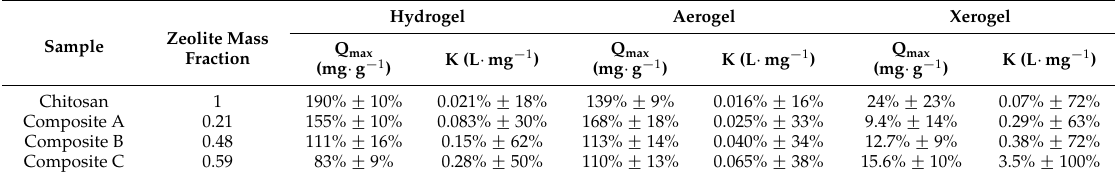
Figure 6. Cu(II) sorption on zeolite X (void lozenges), chitosan hydrogel (filled circles), aerogel (void trangles) and xerogel (filled squares). The lines are best-fit Langmuir curves. Table 3. Langmuir constants for the adsorption of Cu(II) ions a